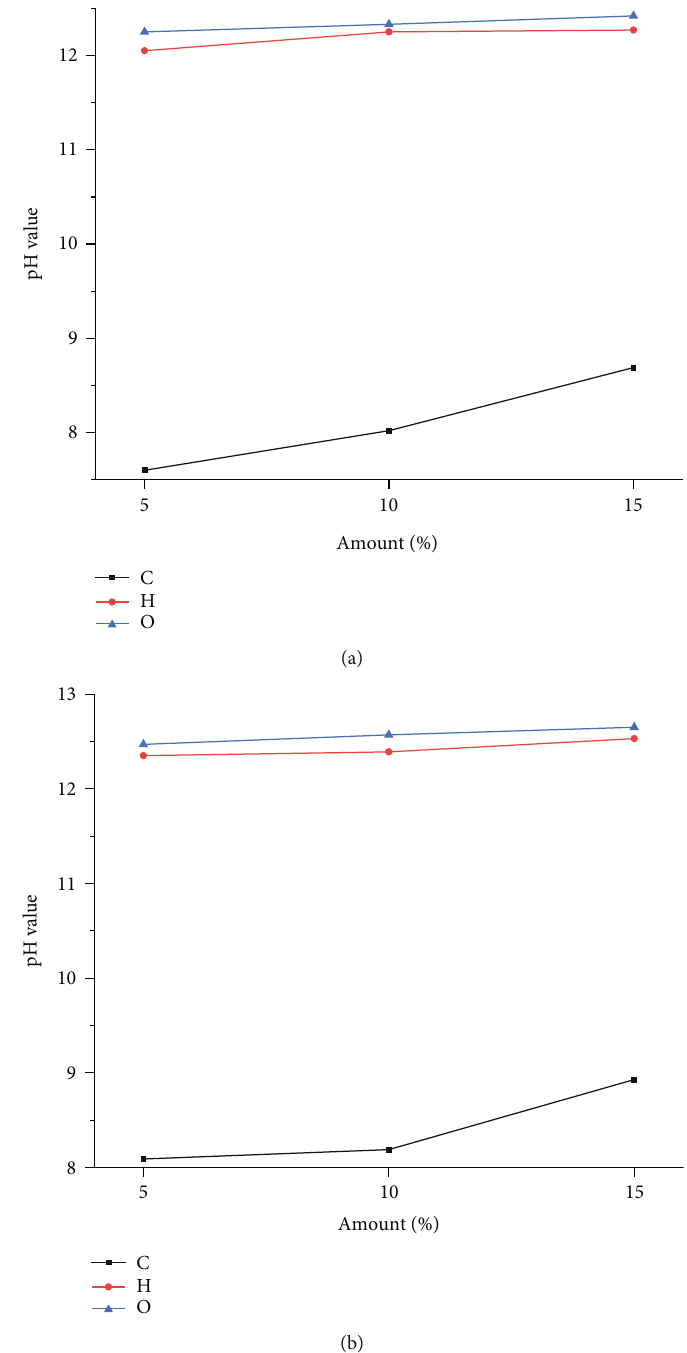
Figure 4: pH at di ff erent pollution concentrations. (a) pH value at 0.1% Zn 2+ concentration. (b) pH value at 0.5% Zn 2+